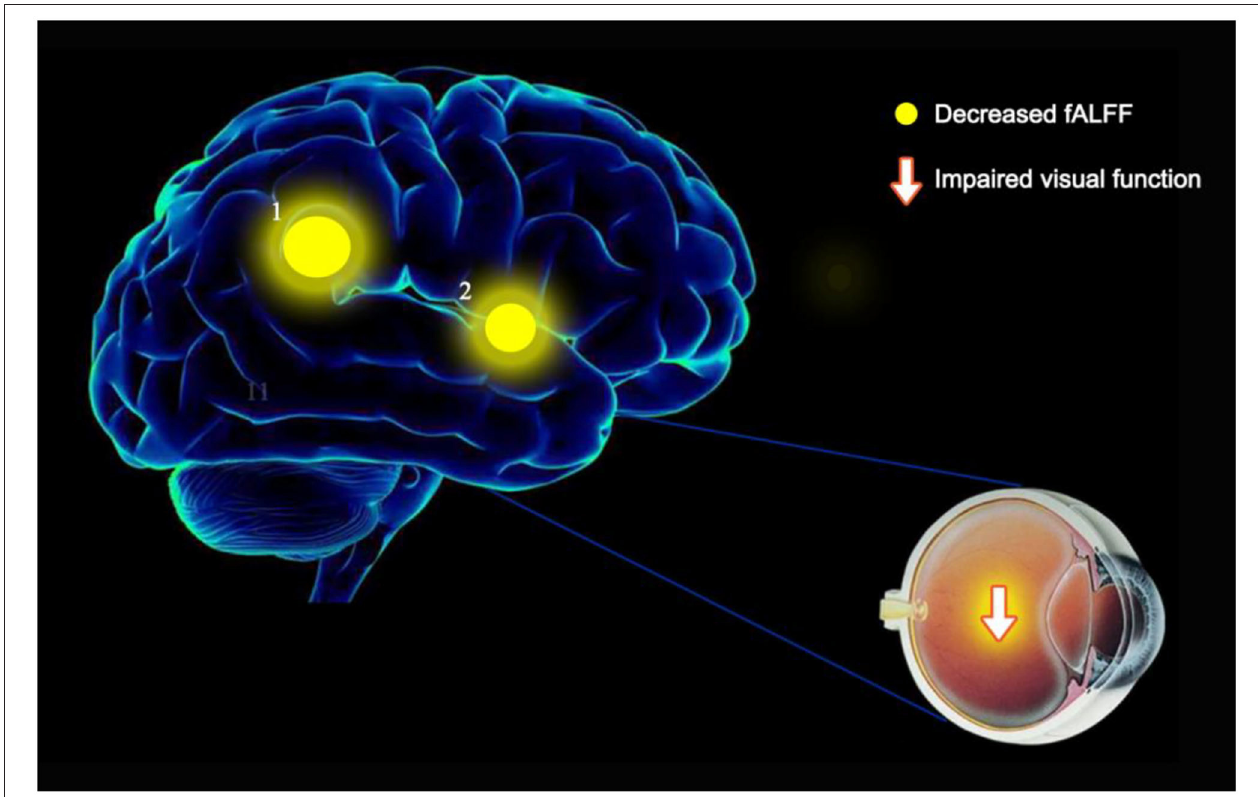
FIGURE 6 | fALFF results of cerebral activity in the OF group. The fALFF values of the cerebral areas in the OF group were in the following: 1- left anterior cingulate gyrus (t = − 4.6941), 2 - right superior temporal gyrus (t = − 4.399). The intensity, as well as the frequency of brain activity, is reflected by the size of spots.